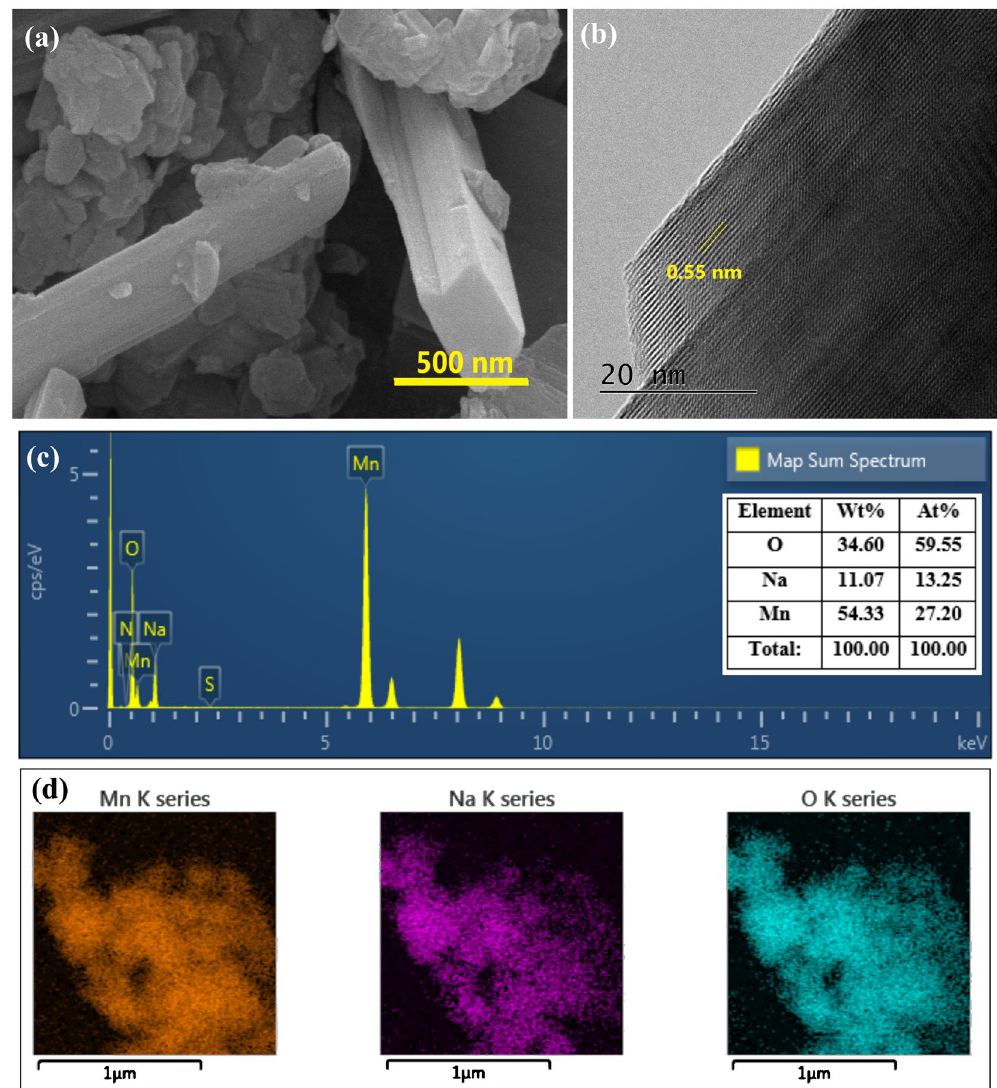
Figure 1. ( a ) SEM micrograph; ( b ) HR-TEM micrograph; ( c ) EDAX analysis; ( d ) 2D elemental mapping of